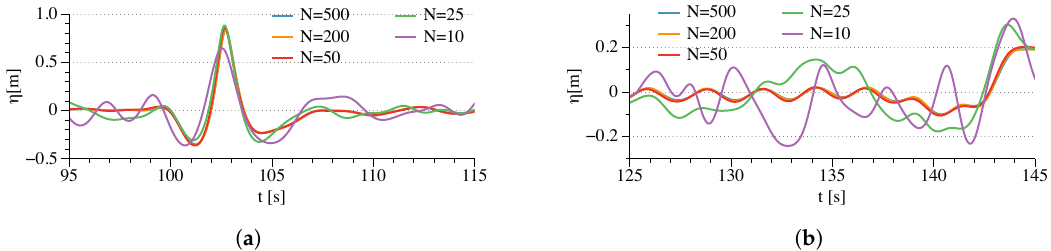
Figure 3. Convergence study for the number of frequency components for the generation of the focused wave group using the wave packet approach, ( a ) time series near the focusing event with a different number of frequency components, ( b ) time series away from the focusing event with a different number of frequency